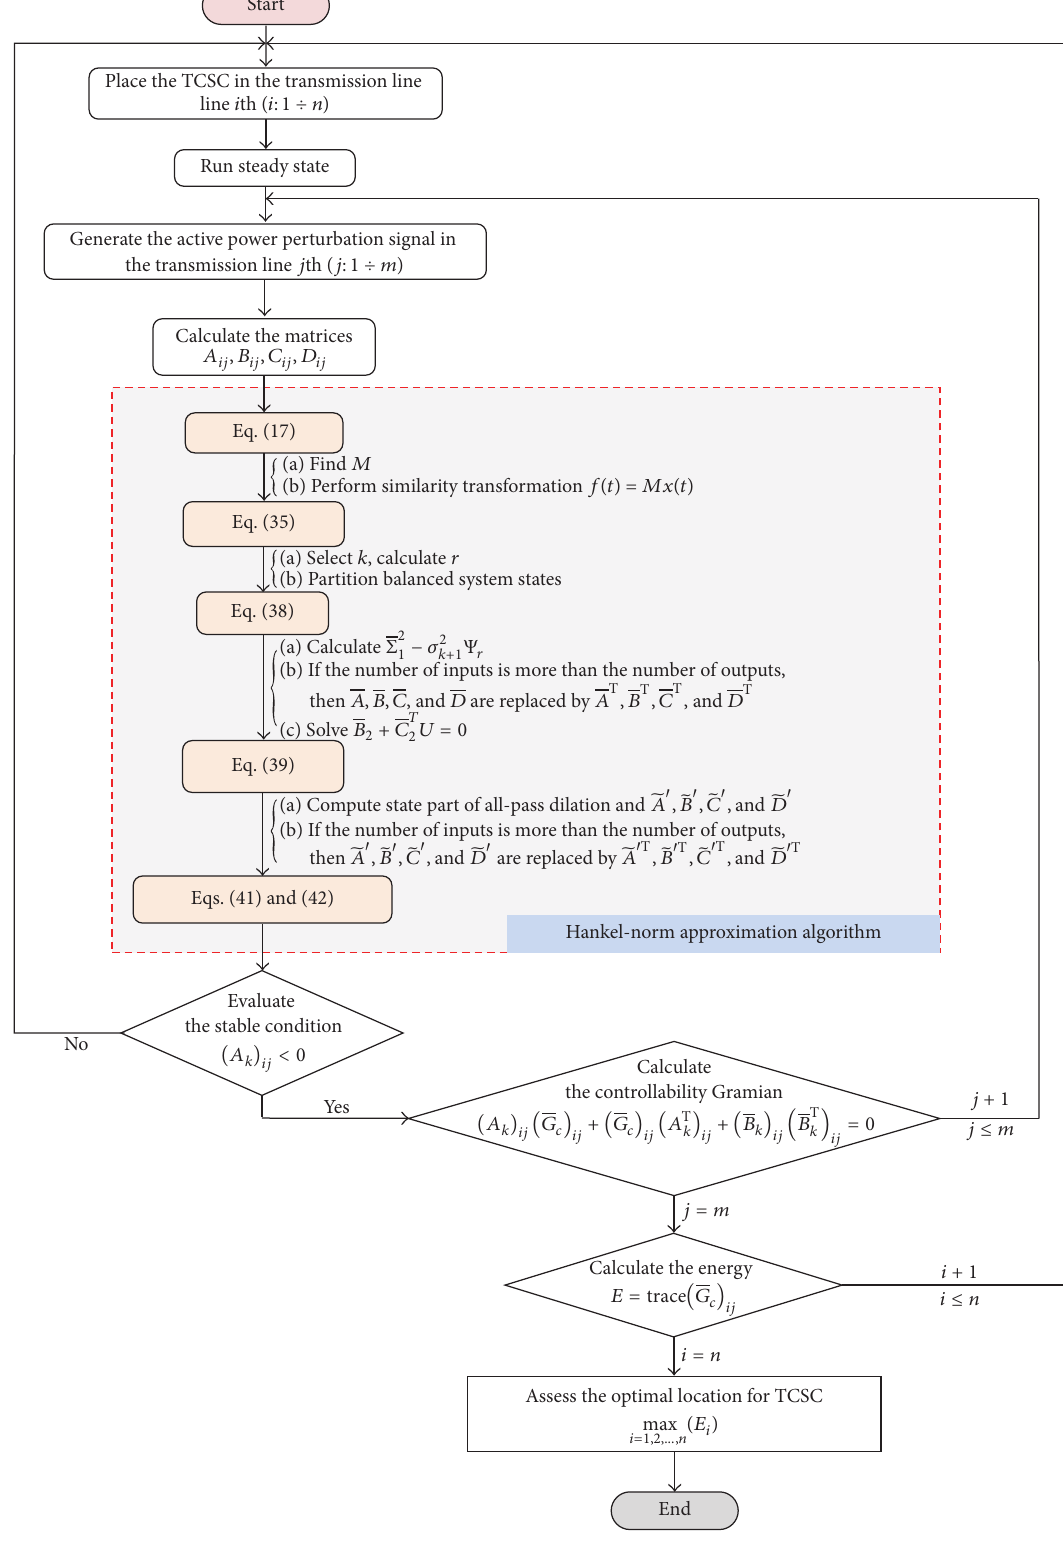
Figure 5: Flowchart of the proposed